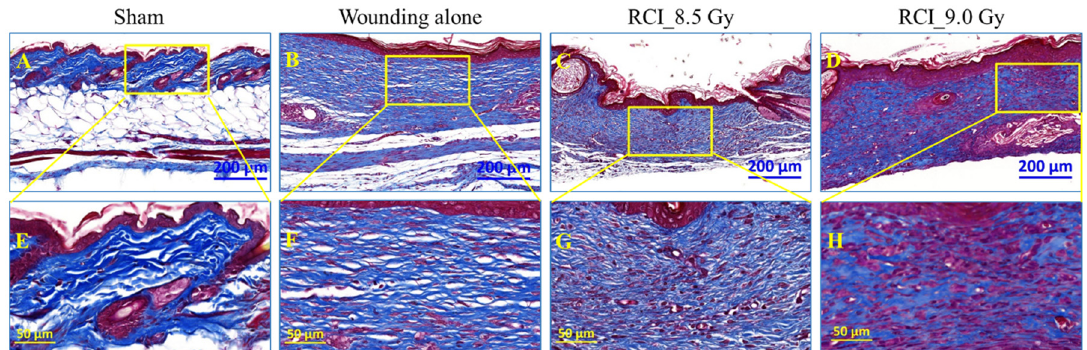
Figure 8. TBI perturbs collagen deposition during wound healing. Collagen morphology/organiza- tion in scars of skin wounds was evaluated by Masson’s trichrome staining (Blue: collagen; Red: cytoplasm; Black: nuclei). ( A – D ) Representative images of histological sections of skin wound scar day 30 after TBI (low magnification) from sham, SW alone, RCI at 8.5 Gy, and RCI at 9.0 Gy groups, N = 3, scale bar: 200 µm. ( E – H ) High magnification images of respective insets displayed in ( A – D ), N = 3/group, scale bar: 50